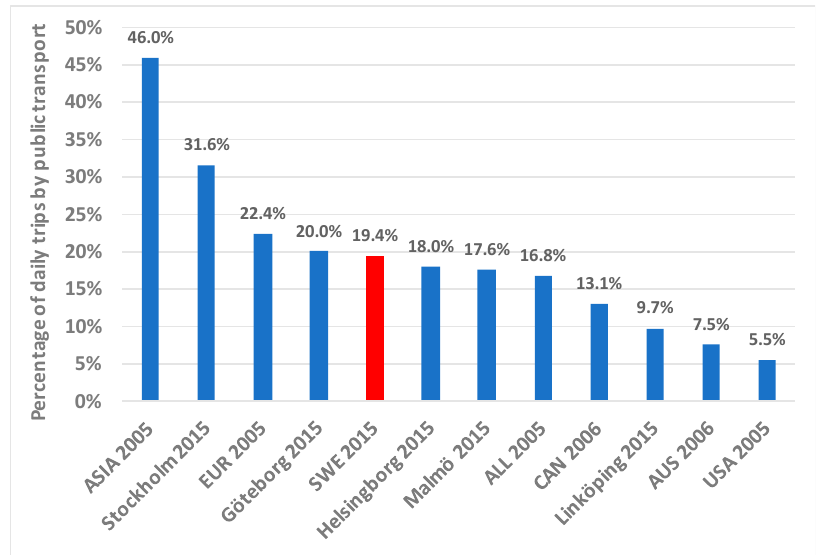
Figure 12. Percentage of daily trips by public transport in five Swedish cities (2015) compared to a sample of global cities (2005–2006).